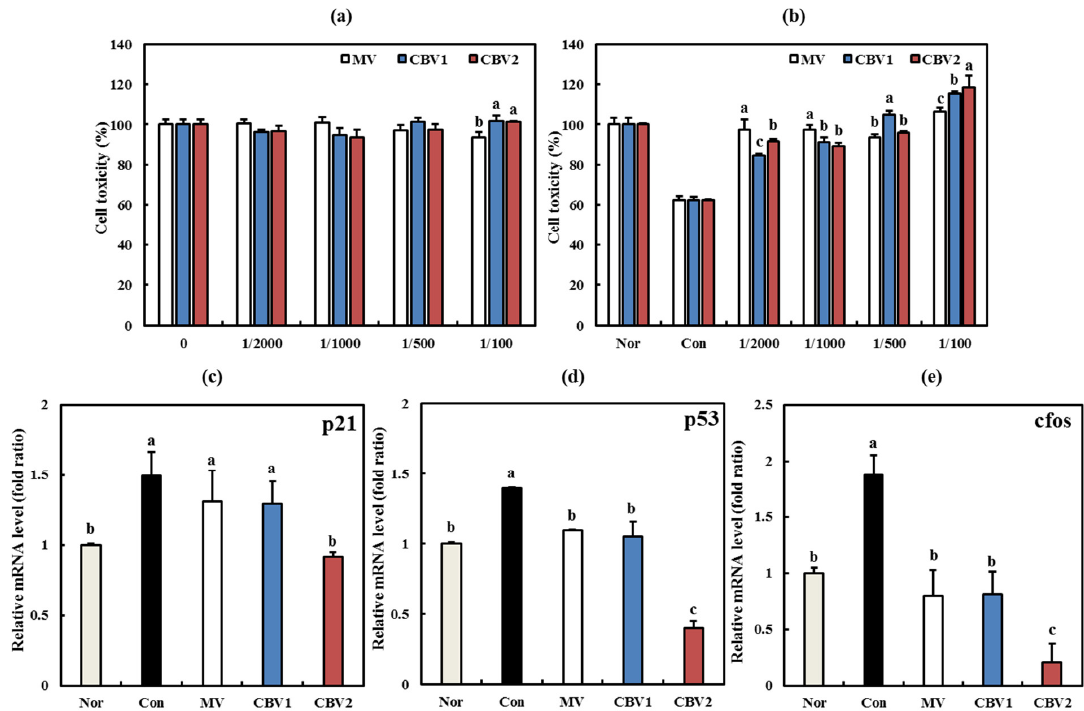
Figure 5. Anti-aging activities of citrus blended vinegars in WI-38 cells. ( a ) Cytotoxicity. ( b ) Cytotoxicity in H 2 O 2 -induced cells. ( c ) p21 mRNA level. ( d ) p53 mRNA level; and ( e ) c-Fos mRNA level. Data are expressed as the mean ± SD. Lowercase letters indicate significant differences among groups ( p < 0.05). Nor—H 2 O 2 not treated; Con—H 2 O 2 treated; MV—H 2 O 2 treated + mandarin vinegar; CBV1—H 2 O 2 treated + blended mandarin vinegar and premature mandarin vinegar in a ratio of 8:2; CBV2—H 2 O 2 treated + blended mandarin vinegar and premature mandarin vinegar in a ratio of 7:3.